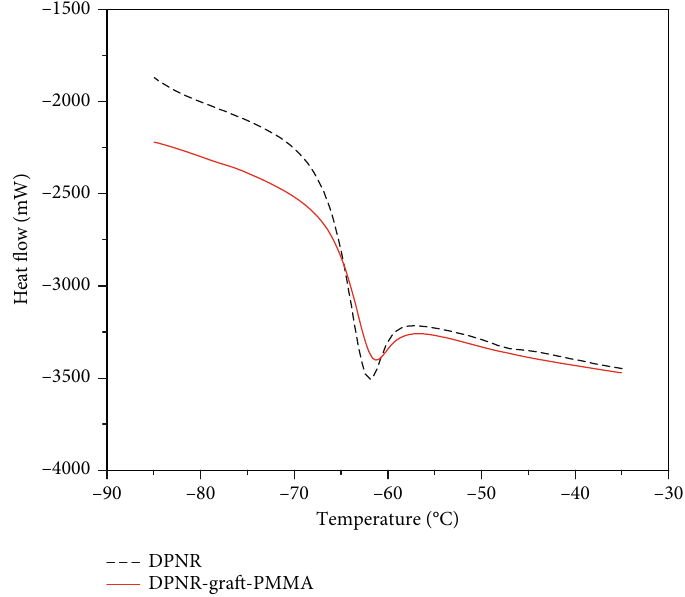
Figure 6: DSC curves of DPNR and DPNR-graft-PMMA 15wt.%.